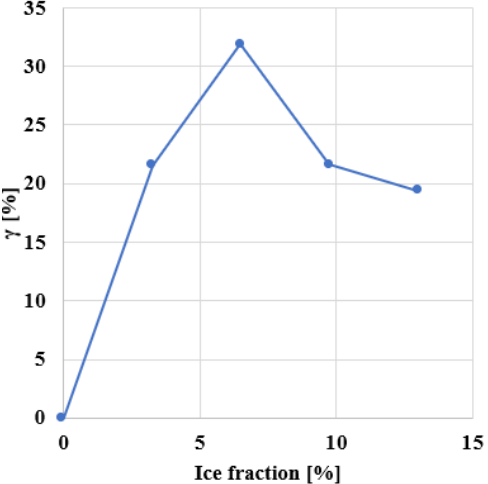
Figure 14. Reduction of peak stress with ice %.